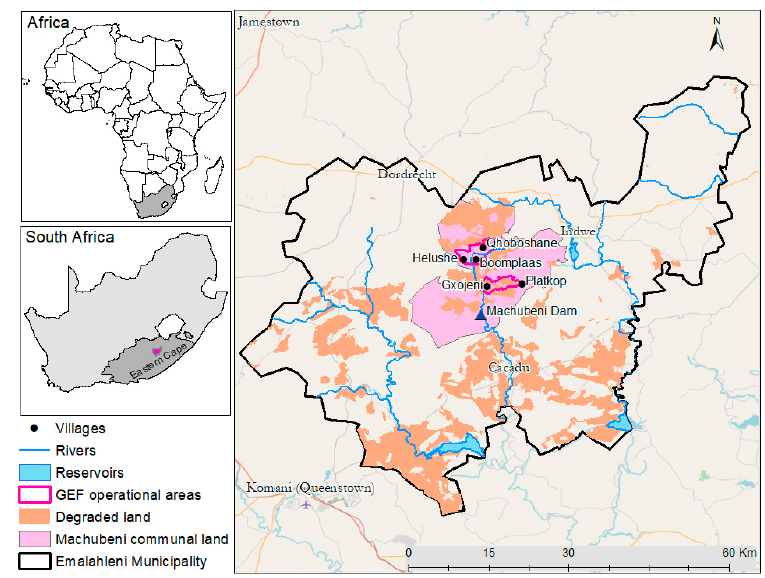
Figure 1. Map showing the location of Machubeni communal lands and the Global Environmental Facility (GEF) operational areas.